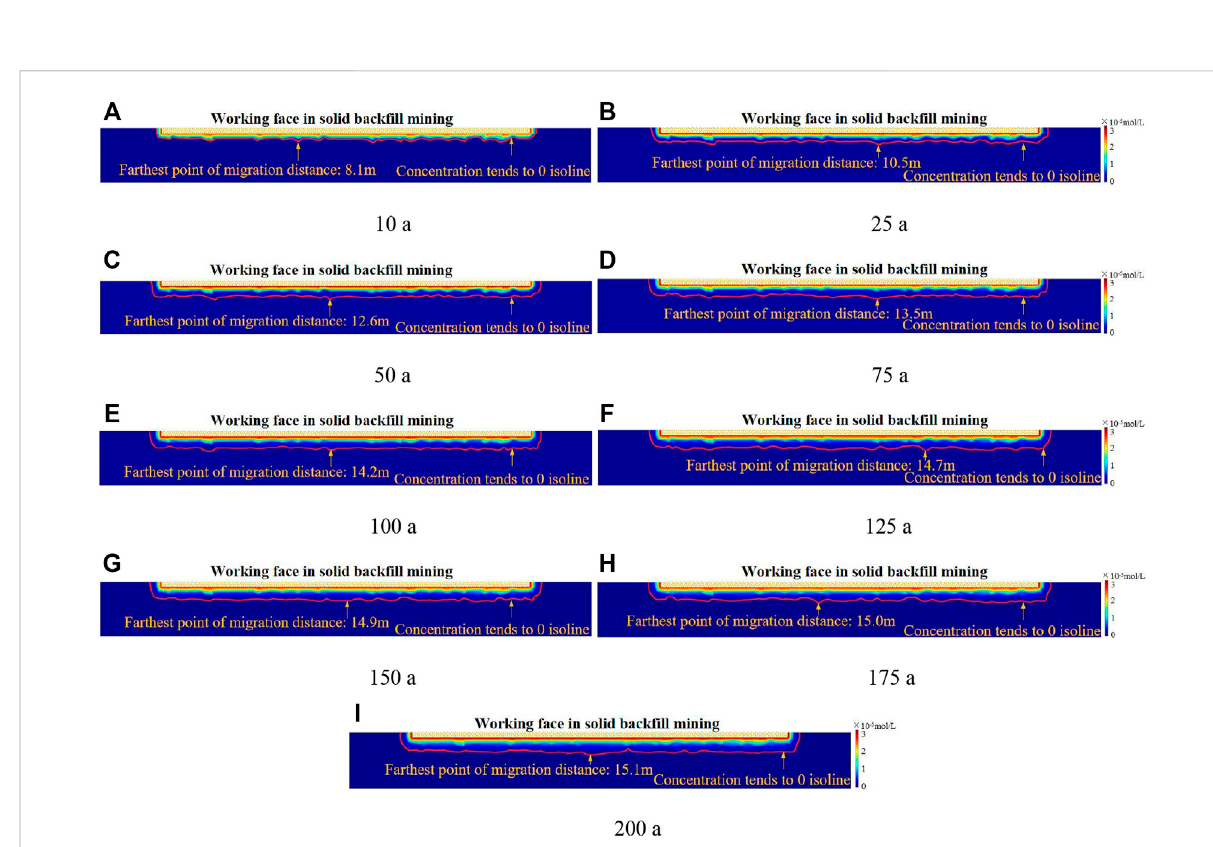
FIGURE 5 The distribution cloud charts of the concentration of Mn ions at different times. (A) 10 a (B) 25 a (C) 50 a (D) 75 a (E) 100 a (F) 125 a (G) 150 a (H) 175 a (I) 200